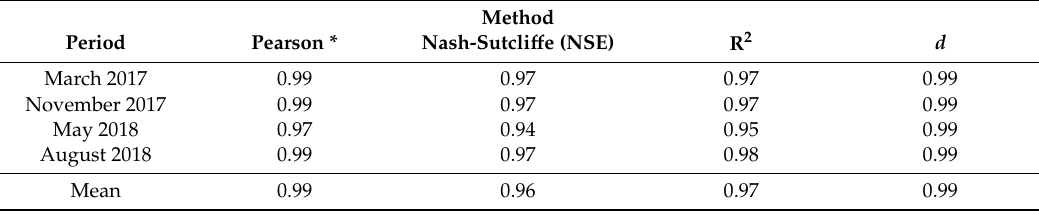
Table 1. Correlation between observed and predicted statistical parameters (2017 and 2018).